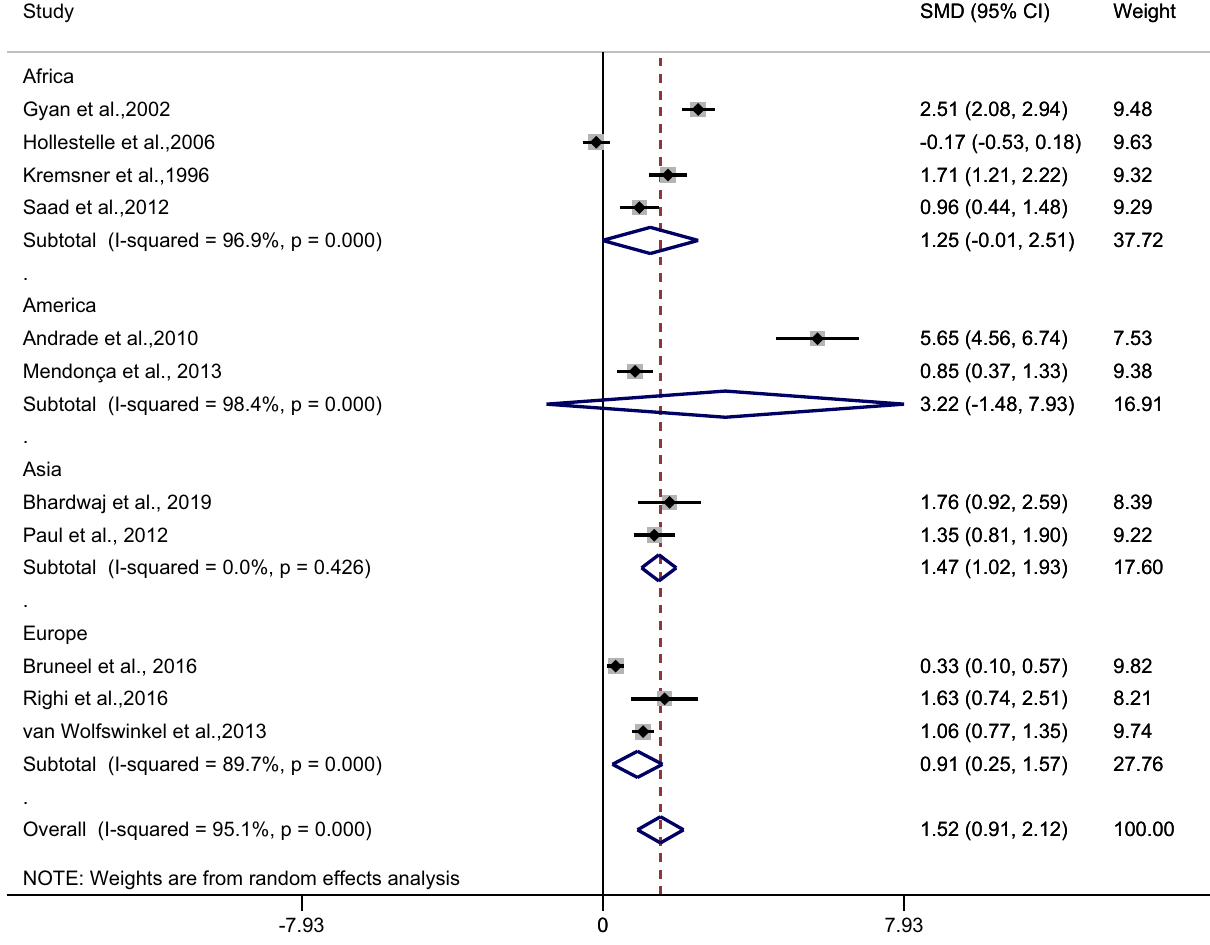
Figure 3. Forest plot demonstrates the difference in the mean CRP level between patients with severe and uncomplicated malaria by continents. SMD, standard mean difference; CI, confidence